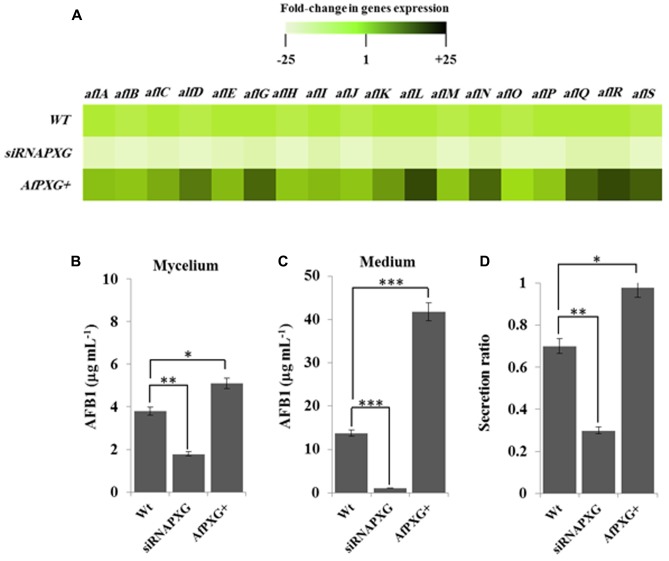
The increased lipid droplet (ILD)-phenotype in A. flavus AfPXG+ is positively correlated with biosynthesis and secretion of AF. (A) Transcripts levels of the AFB1-biosynthesis genes in fungal tissue of the A. flavus AfPXG+ line compared with AfPXG2-silenced and WT lines were evaluated by qRT-PCR. Three measurements were taken in three cDNAs prepared from three individual fungal growth for each line. Each point was triplicated and the average of CT was taken. The relative quantification RQ=2(-ΔΔCT) of the target gene was calculated using installed software from an Applied Biosystems StepOne cycler, United States. The color scale (white–green–black) indicates relative changes of transcript abundance of -25-, 1-, and +25-fold, respectively. For each gene, the expression level in WT was defined as 1, and the corresponding abundance changes under treatments were calculated directly using the software installed in the Applied Biosystems qPCR system. (B,C) Quantification of AFB1 production in the fungal mycelium and in the culture medium of A. flavus AfPXG+ line compared with AfPXG2-silenced and WT lines. (D) Secretion ratio of AFB1 by the three fungal lines (calculated as ratio of AFB1 in the medium to AFB1 in medium plus mycelia in a 100 mL culture). All measurements were performed in triplicate and the presented data are means ± SD (n = 3). The differences in AF production between lines were significant when analyzed by t-test (∗P < 0.05; ∗∗P < 0.01; ∗∗∗p < 0.001).